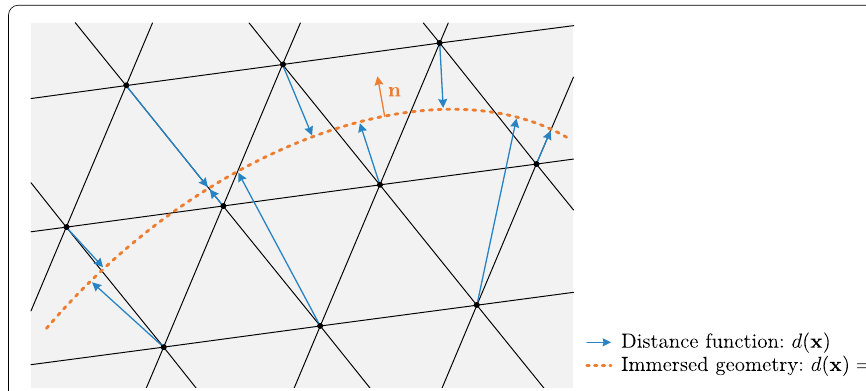
Fig. 1 Distance function to implicitly describe an immersed geometry